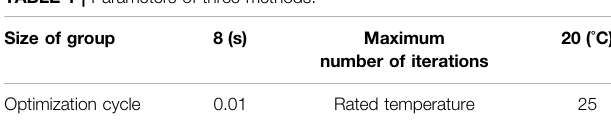
TABLE 1 | Parameters of three